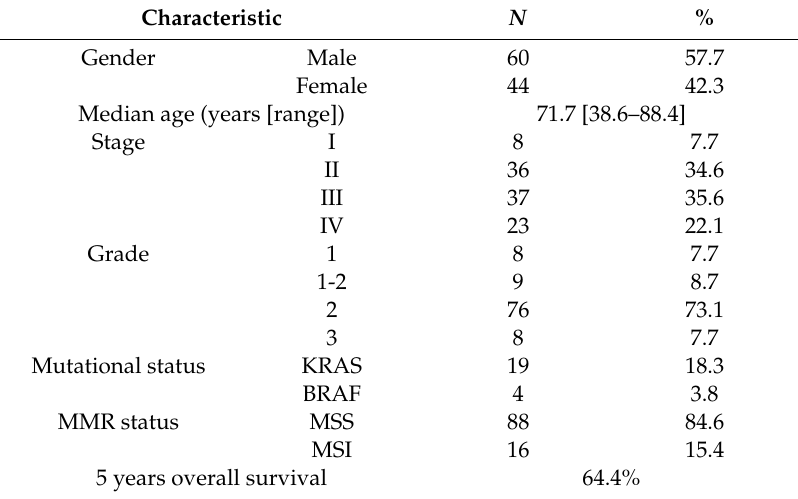
Table 1. Demographic and clinical features of colorectal cancer